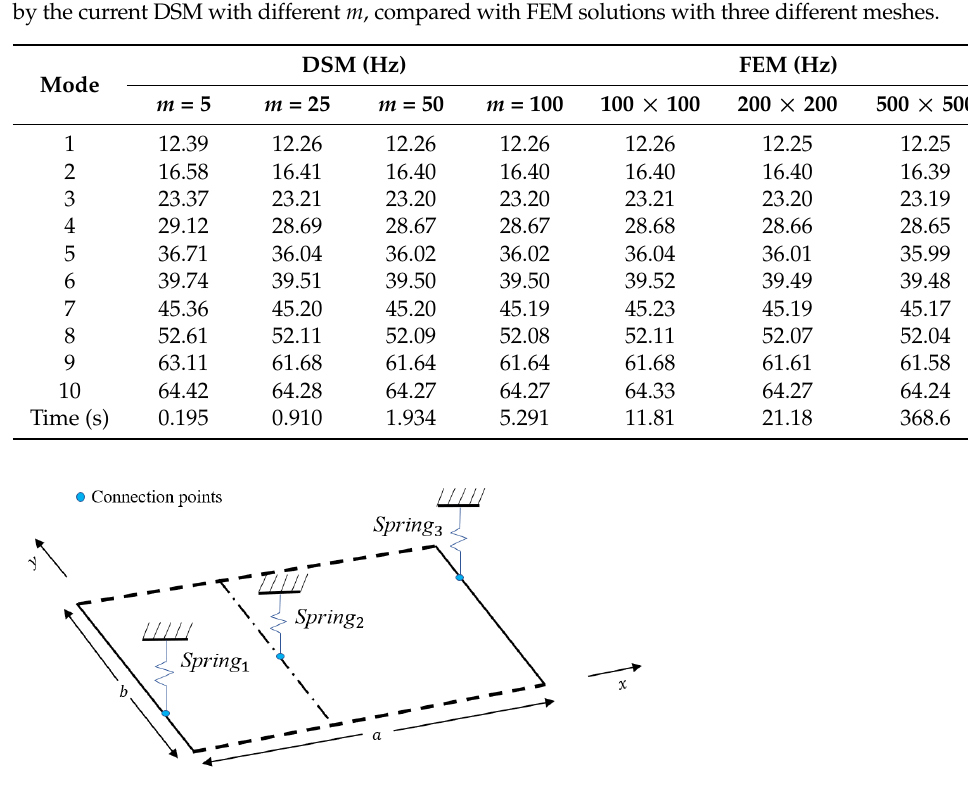
Figure 12. A plate supported by elastic spring supports at three points, i.e., (0,0.25,0), (0.4,0.5,0) and (1,0.75,0).